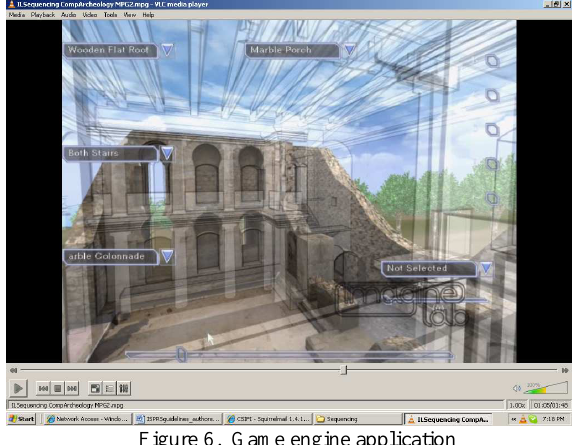
Figure 6. Game engine application